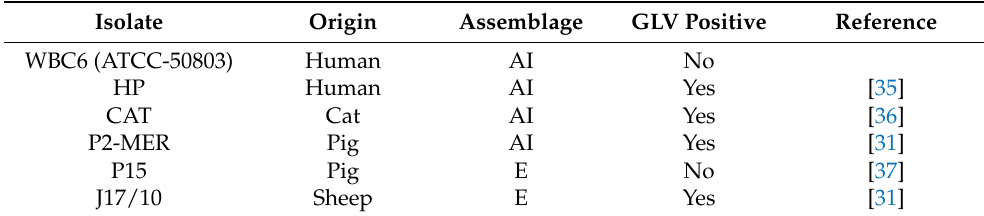
Table 1. List of G. duodenalis isolates used in the present